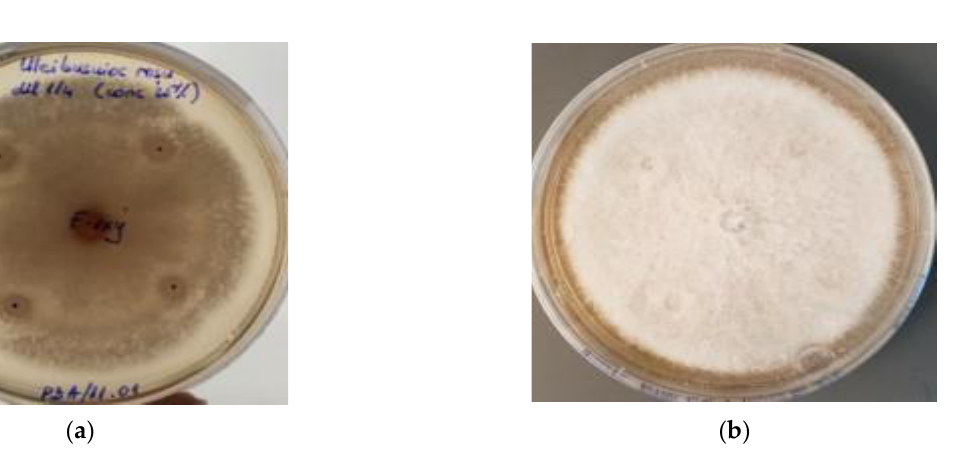
Figure 8. Basil essential oils (EOs) evaluation against the pathogen F. oxysporum on CGA medium, tested at different concentrations.